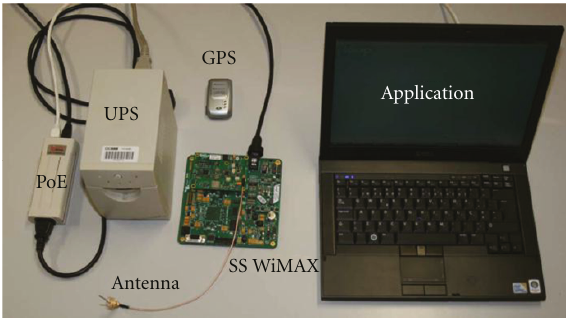
Figure 15: Portugal Telecom Inovac¸˜ao’s OptiMax tool.